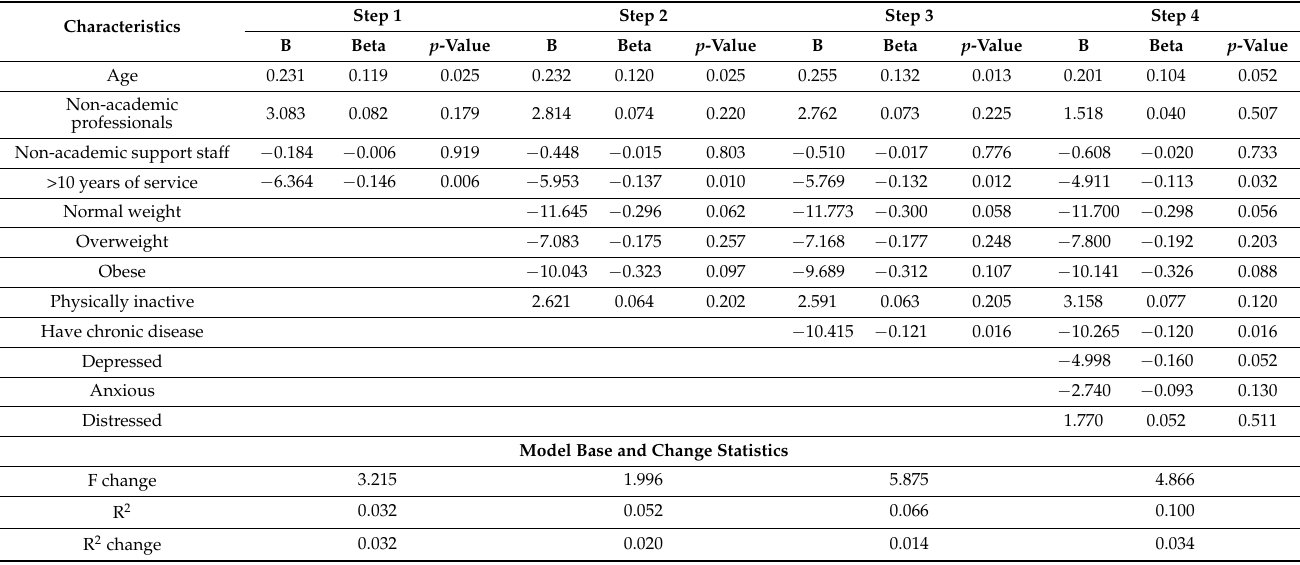
Table 6. Factors associated with social relationships HRQoL according to the hierarchical multiple linear regression